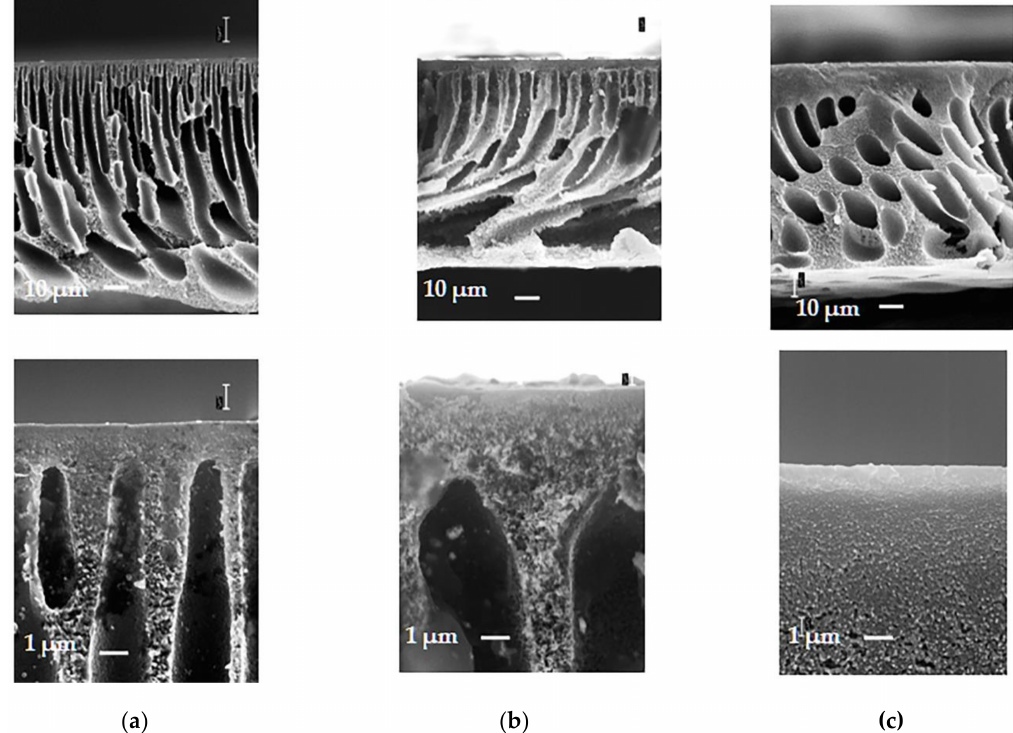
Figure 7. SEM-images of the cross-section and enlarged fragment of cross-section (selective layer) of membranes prepared from a polymer solution with the addition of 15 wt% PEG-400 in NMP (series B), PPSU:PSF ratio: ( a )—0:100 (PSF-PEG); ( b )—50:50 (B50); ( c )—100:0